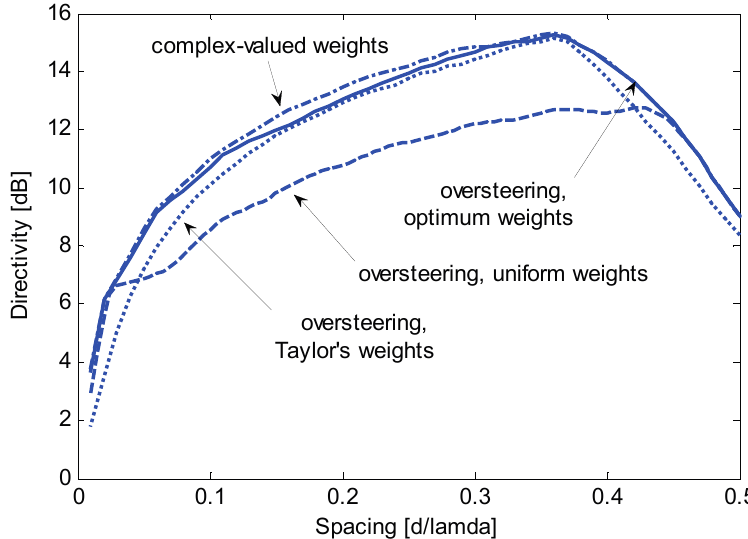
Figure 6. Maximum constrained directivity obtained for an end-fire array of N = 8 sensors by imposing WNG ≥ 0 dB using the oversteering technique with optimum weights (solid line), uniform weights (dashed line), and Taylor’s weights (dotted line); the performance without oversteering obtained with optimum complex weights is included for comparison (dash-dotted